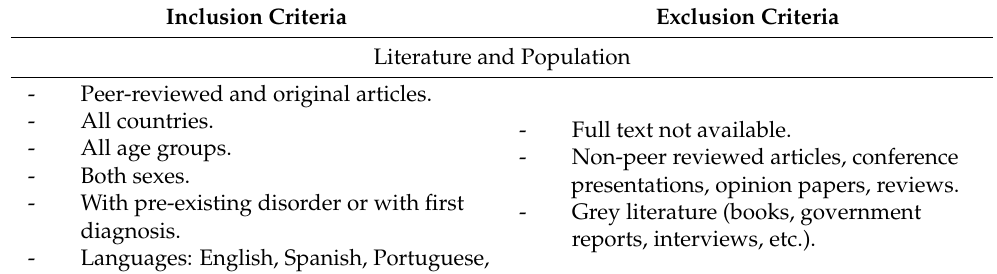
Table 1. Eligibility criteria: inclusion and exclusion criteria for the selection of